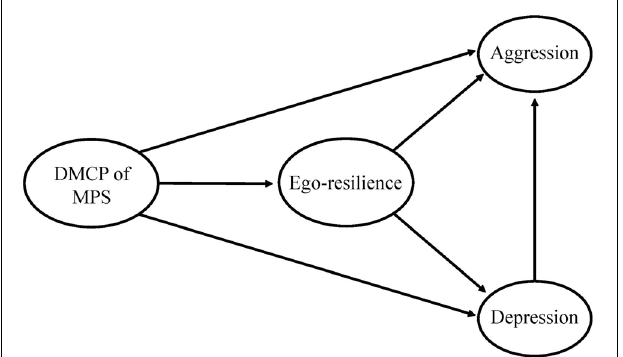
FIGURE 1 | The research